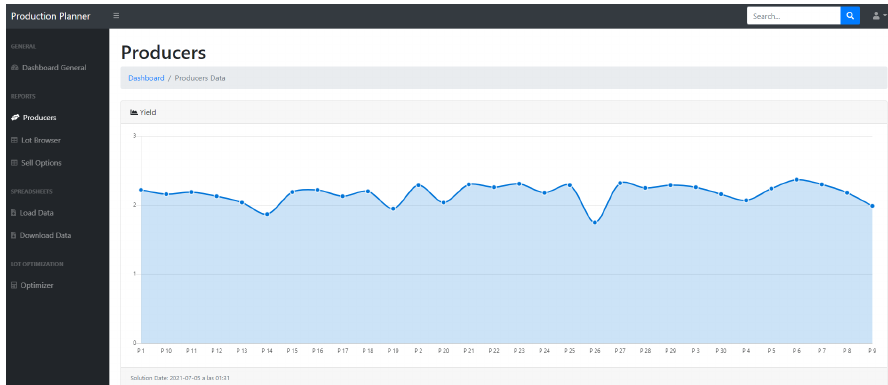
Figure 9. Profitability per kilogram of each